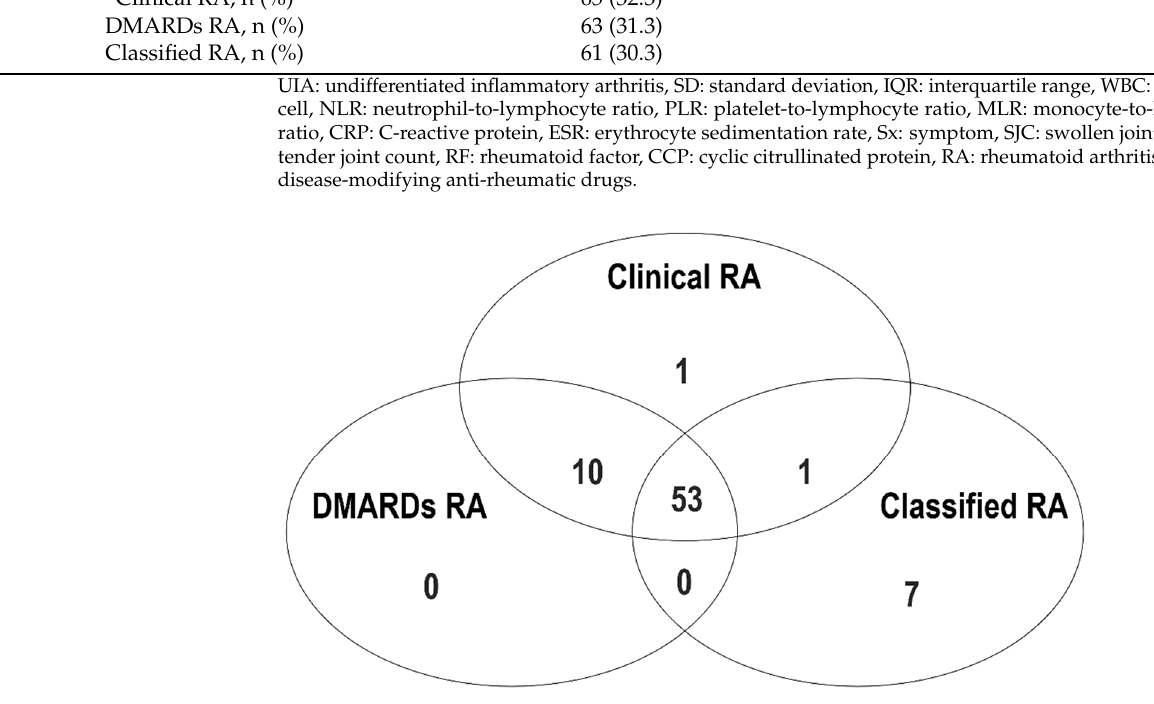
Figure 1. Proportion of “clinical RA”, “DMARDs RA”, and “classified RA” among patients with early inflammatory arthritis.